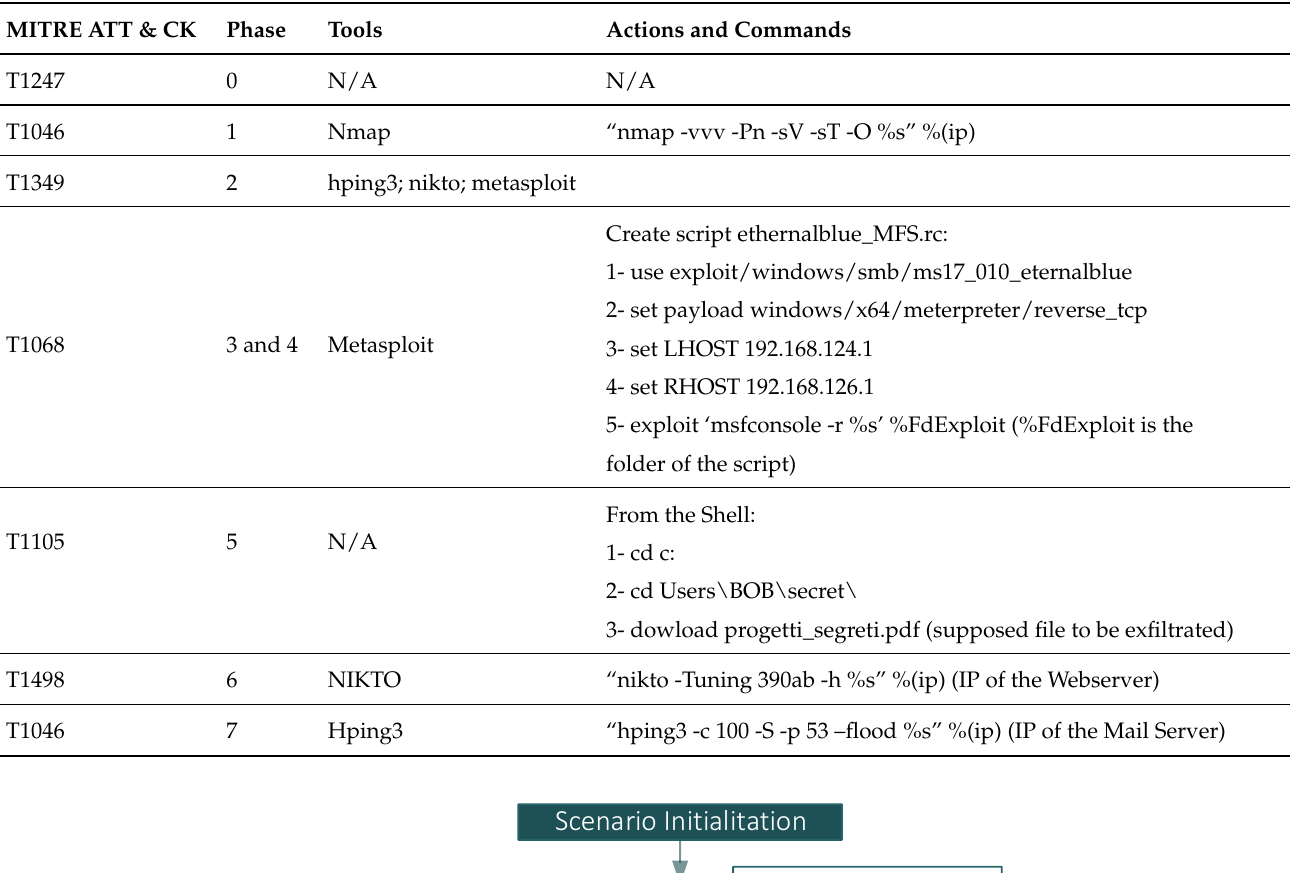
Table 2. Detailed steps to perform the attack in Scenario 1.